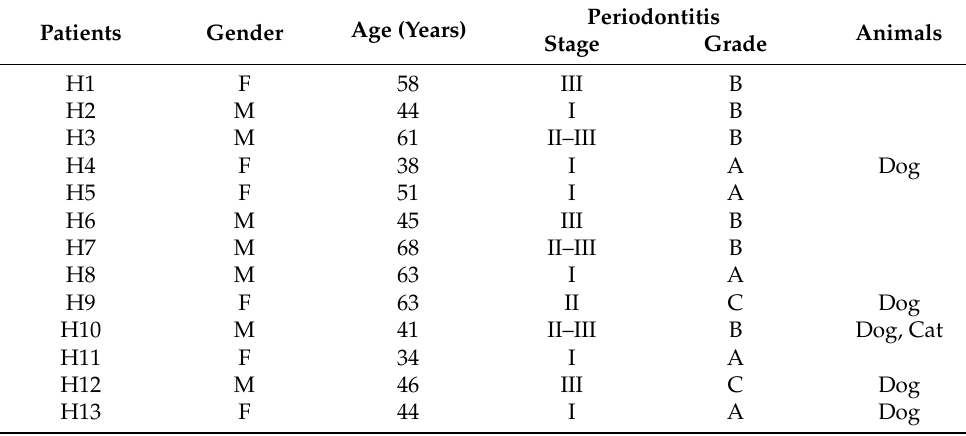
Table 2. General information about patients and their periodontal status.